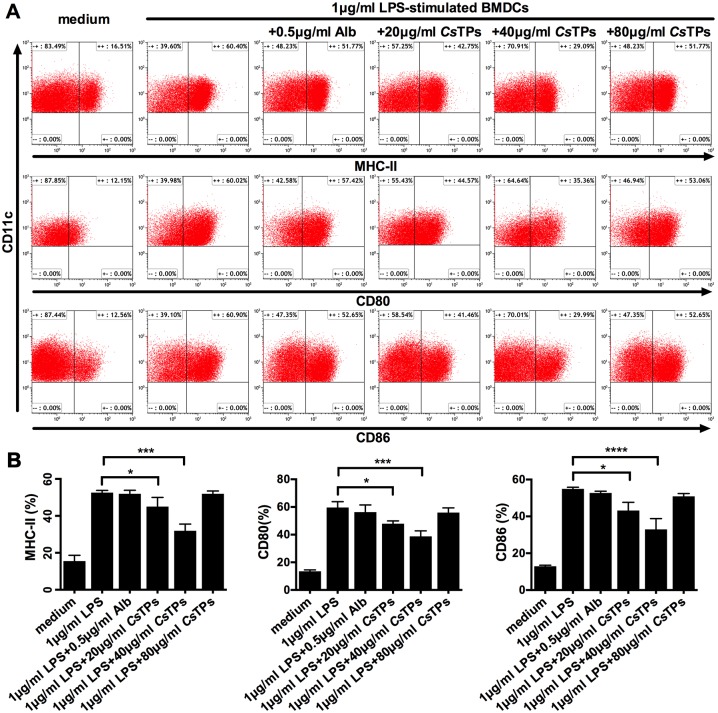
Effect of CsTPs on expressions of co-stimulatory molecules on LPS-induced BMDCs.(A) Representative images of co-stimulatory molecules MHC-II, CD80 and CD86 on BMDCs detected by FACS. one marrow cells from BALB/c mice were cultured with IL-4 and GM-CSF. At Day 7, immature BMDCs were harvested and 1 × 106/ml cells were treated with 20, 40 or 80 μg/ml CsTPs or 0.5 μg/ml Alb (control protein) in the presence of 1μg/ml LPS as a maturation factor or medium alone for 24 h. The maturation phenotype of CD11c+ BMDCs were assessed by FACS for the expressions of co-stimulatory molecules MHC-II, CD80 and CD86. (B) Statistical analysis of expression percentages of the surface markers on CD11c+ BMDCs. Data are shown as mean ± SD of three independent experiments. Statistical significance was analyzed by one-sided paired Student’s t-test (*, P < 0.05; **, P < 0.01; ***, P < 0.001; ****, P < 0.0001 vs. LPS group).